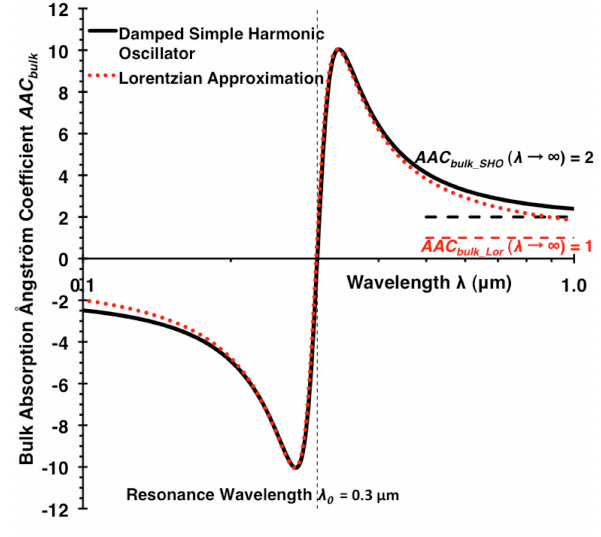
Fig. 2. Real (top lines) and imaginary (bottom lines) refractive in- dices for the damped simple harmonic oscillator (solid black lines) and its Lorentzian approximation (dotted red lines) as a function of wavelength λ (logarithmic scale) with the resonance wavelength λ 0 = 0 . 3µm shown as vertical dashed line and the long wavelength limits of n as horizontal dashed lines.